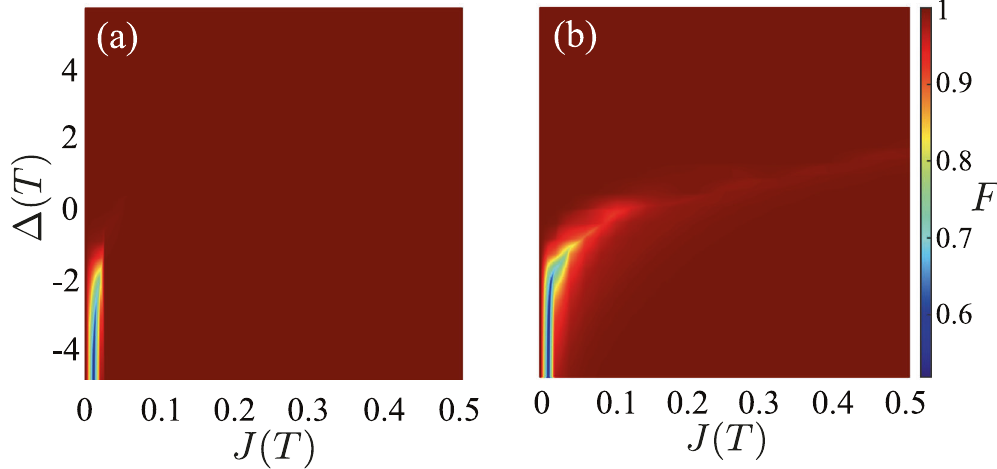
Fig. 7 Maximal fi delity with different ramping indices and trajectories. Maximal fi delity of the prepared state F vs target hopping rate J ( T ) and target detuning Δ ( T ): a among all data in Figs. 4a – d and 6a – d, and b between the linear ramping data in Figs. 4c and